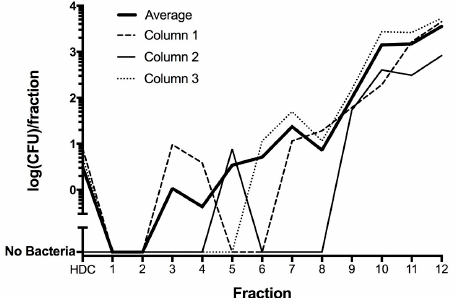
Figure 6. Purification of HDCs by sedimentation through a column. The number of bacteria decreased over the length of the column, such that no bacteria are present in the first and second fractions. Each fraction was approximately 0.5 mL in volume, except for the “HDC fraction”, which was taken from fraction 1 and contained the HDCs in a volume of 130 uL.